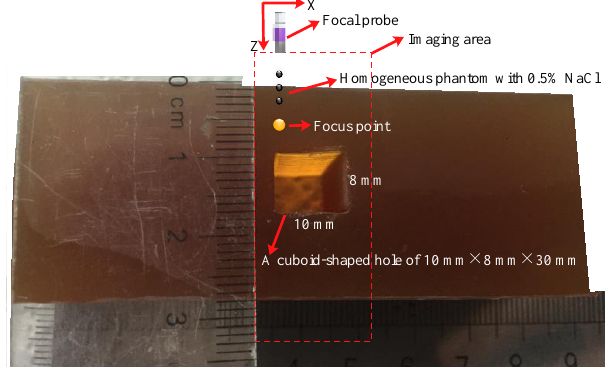
Figure 11. The uniform phantom for testing.